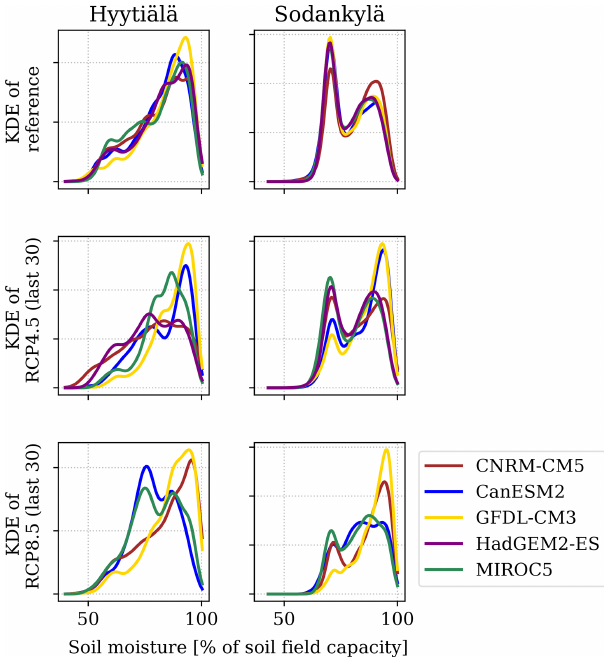
Figure 7. KDE estimates of the JSBACH soil moisture values (rel- ative to soil field capacity) for the reference period and the last 30 years of simulations. Each colour represents the average summer- time (June–August) soil moisture, produced with one of the climate models using all